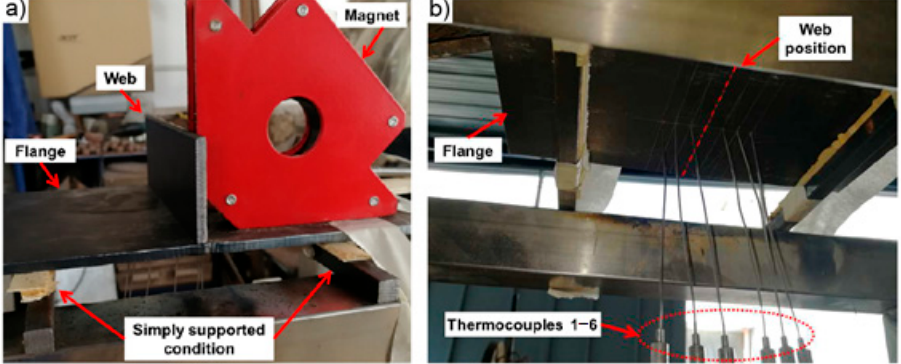
Figure 3. Experimental set-up before welding: ( a ) upside and ( b ) underside views.